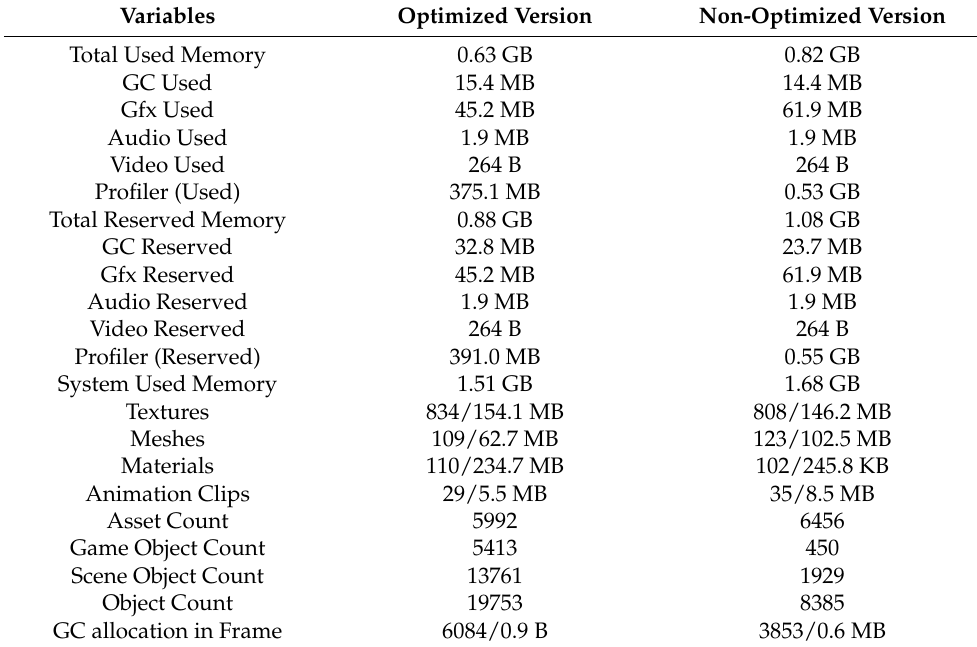
Table 3. Memory data for both versions from the beginning frame in the CPU usage